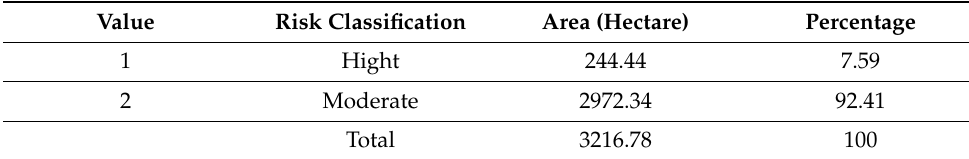
Table 4. Areas under different malaria risk in Sussundenga